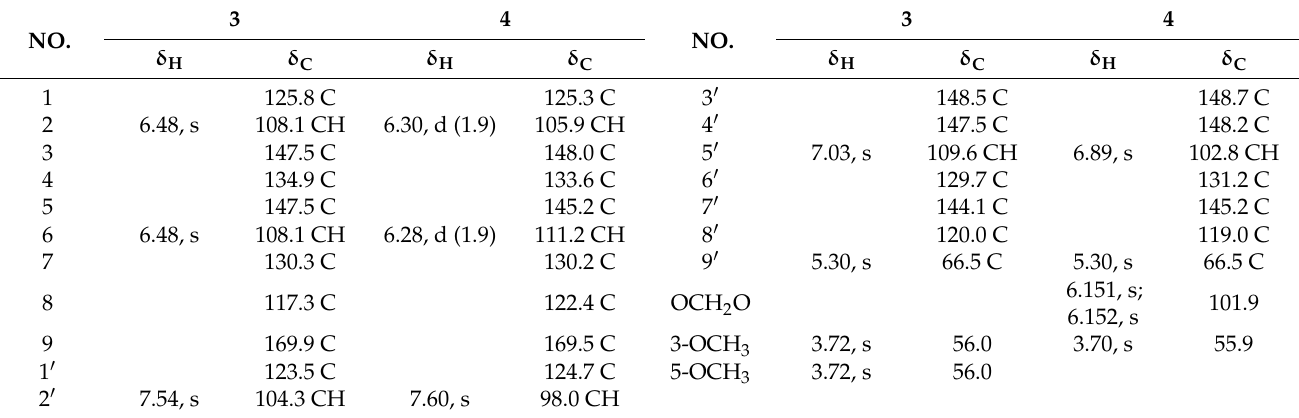
Table 2. 1 H NMR (500 MHz) and 13 C NMR (125 MHz) data (DMSO- d 6 ) of 3 –